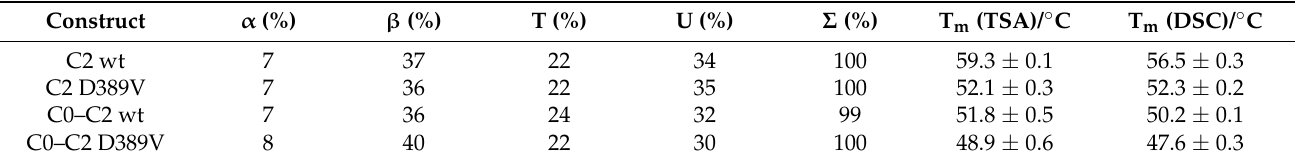
Table 1. Structural and thermodynamic analysis of N-terminal MyBPC domains as determined by CD experiments, TSA and DSC. α : α -helix, β : β -sheet, T: turn, U: unordered, Σ : total, T m : melting temperature. Data are mean ± SEM of at least n = 3